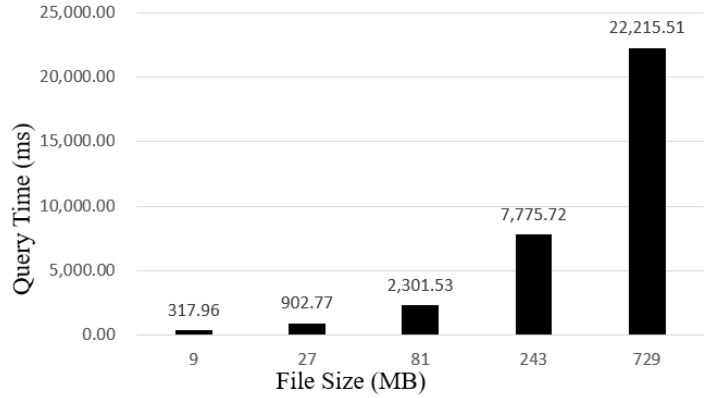
Figure 10. The relation between file size and query time.